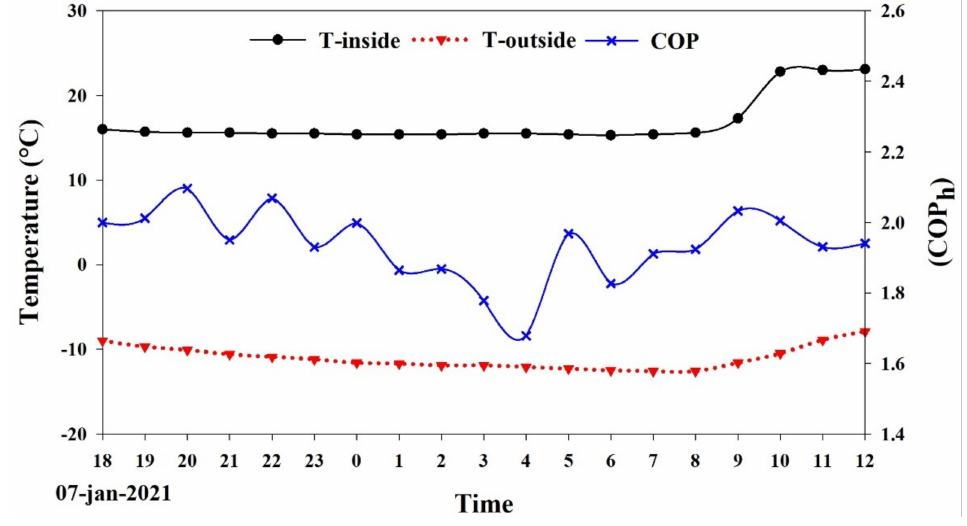
Figure 15. COP of heat pump.